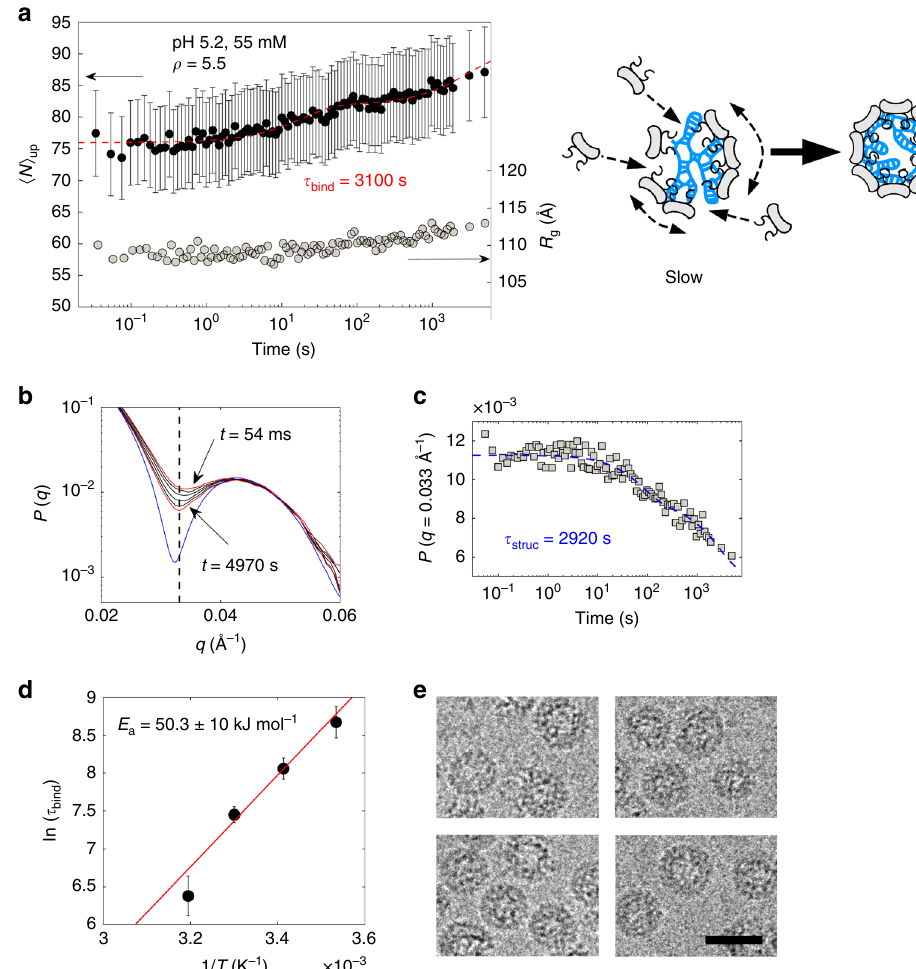
(black discs) and R g (light gray discs) vs. time after mixing pre-assembled NPCs with a buffer Fig. 3 Relaxation dynamics of NPCs into virions. a N h i up solution bringing the pH to 5.2 and the ionic strength to 55 mM. ρ = 5.5 and the temperature was 20 °C. The red dashed line is a double exponential decay function yielding the binding time τ bind as the longest decay time. The drawing illustrates the synchronous pathway where NPCs are self-organizing while capturing free subunits in order to form virions. b Form factors P ( q ) of NPCs (red and black solid lines) at different time points (see Supplementary Fig. 8 for methodological details). The red solid lines correspond to the fi rst and last measurements collected at 54 ms (top curve) and 4970 s (bottom curve), respectively. The blue solid line is the form factor of puri fi ed virions and the black dashed line indicates q = 0.033 Å − 1 . c Value of the form factors of NPCs at q = 0.033 Å − 1 vs. time. The blue dashed line is a double exponential decay fi t yielding an estimate for the structural relaxation time τ struc . d Logarithm of